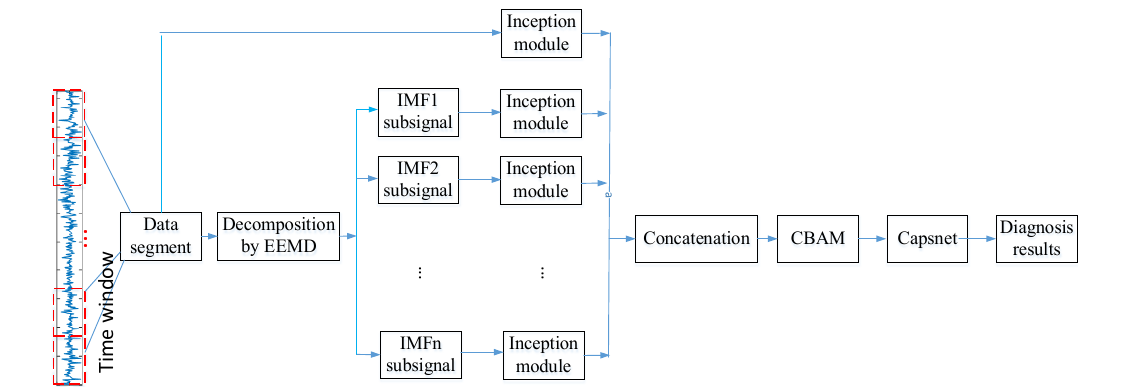
Figure 1. Diagnosis flowchart of attentional feature fusion with inception based on Capsnet.